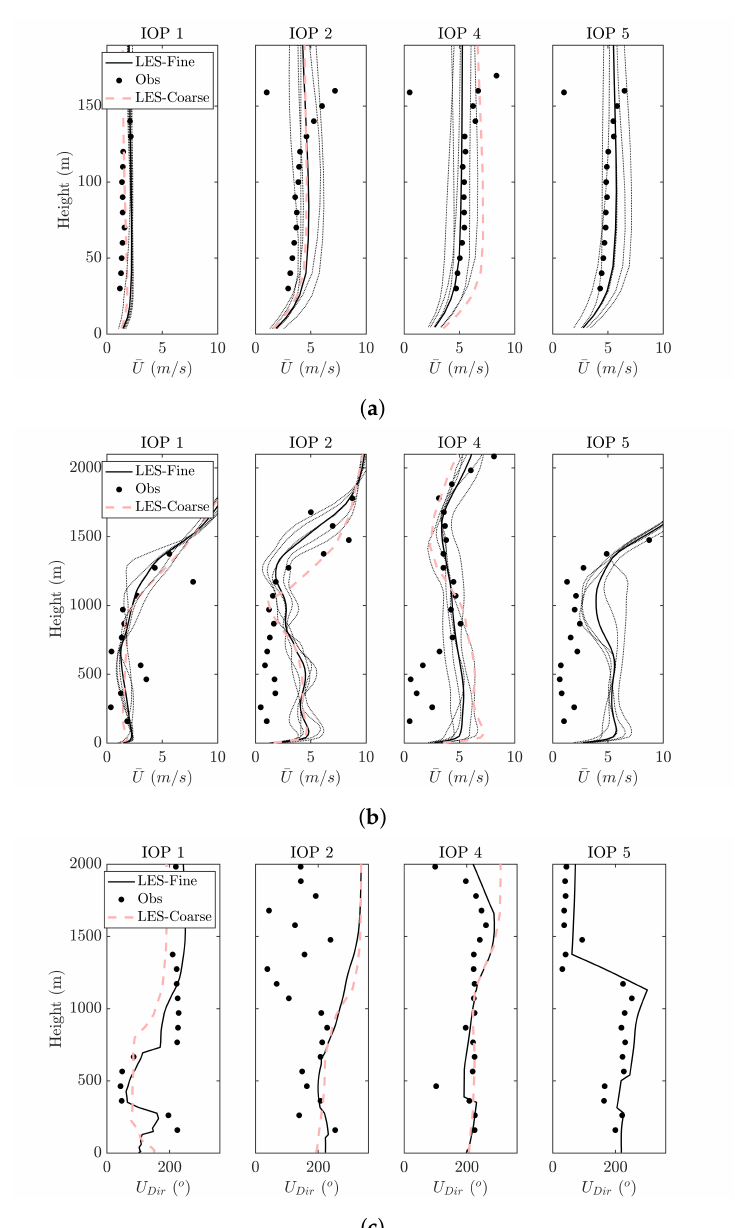
Figure 4. Horizontal Wind Speed profiles of 2.5-h time-averaged from coarse- (red-dash) and fine-LES (solid) runs compared against: the SODAR readings ( a ); and RASS wind profiler ( b ). ( c ) Wind direction profiles of 2.5-h time-averaged compared against the RASS wind profiler. The black dotted lines represent the 30-min averaged wind